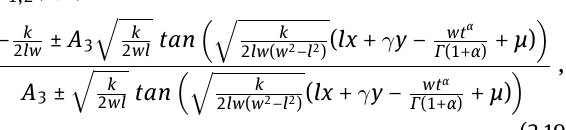
Fig. 2: The solution U 5 ( x , 0, t ) in (3.17) for l =2, k =2, a =1, µ =1, w = 3.5 and −5 ≤ t , x ≤ 5